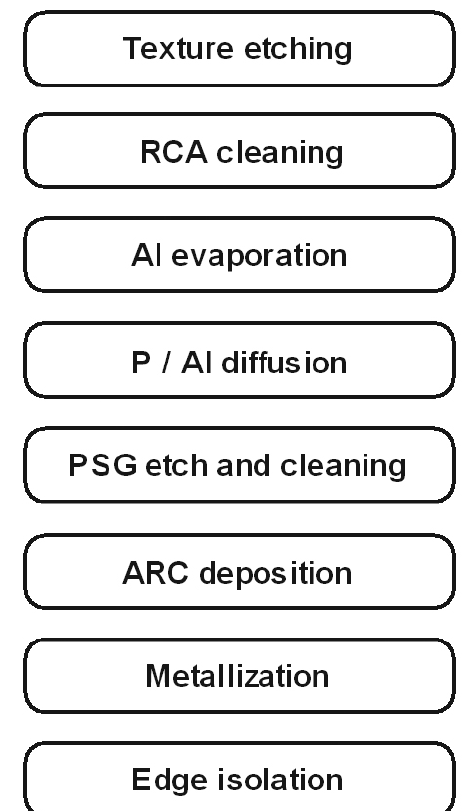
Figure 4. Electrical characteristic of the n + pp + solar cell at standard conditions.